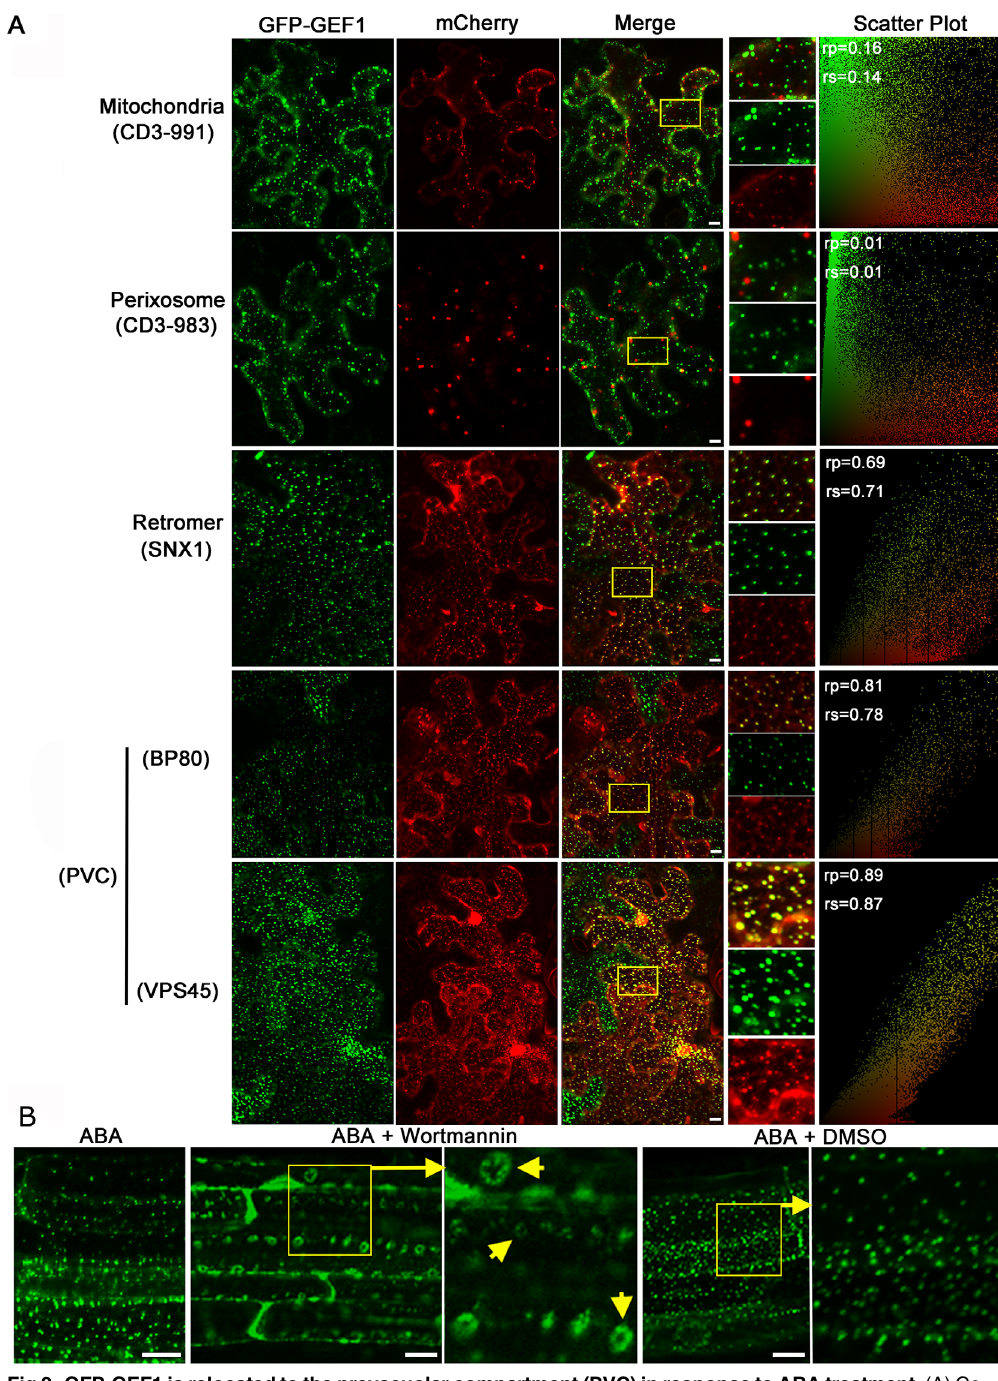
Fig 2. GFP-GEF1 is relocated to the prevacuolar compartment (PVC) in response to ABA treatment. (A) Co- localization assays of GFP-GEF1 with the indicated organelle markers in N . benthamiana leaf epidermal cells in response to ABA. GFP-GEF1 was co-expressed with mCherry-labeled organelle markers in N . benthamiana leaf epidermal cells. N . benthamiana leaves were treated with 50 μ M ABA for 1 h before confocal imaging. Co- localization is visible as yellow dots in the merged images (Merge). Organelle marker names are listed in parentheses on the left. PVC, pre-vacuolar compartment. Representative images are shown of three independent co-localization experiments. (see Methods). Yellow boxes indicate approximate regions amplified to the right of merged images. Levels of co-localization for yellow boxed regions are depicted in relative intensity ( x- , y -axes) scatter plots. Values of the linear Pearson correlation coefficient (rp) and the non-linear Spearman ’ s rank